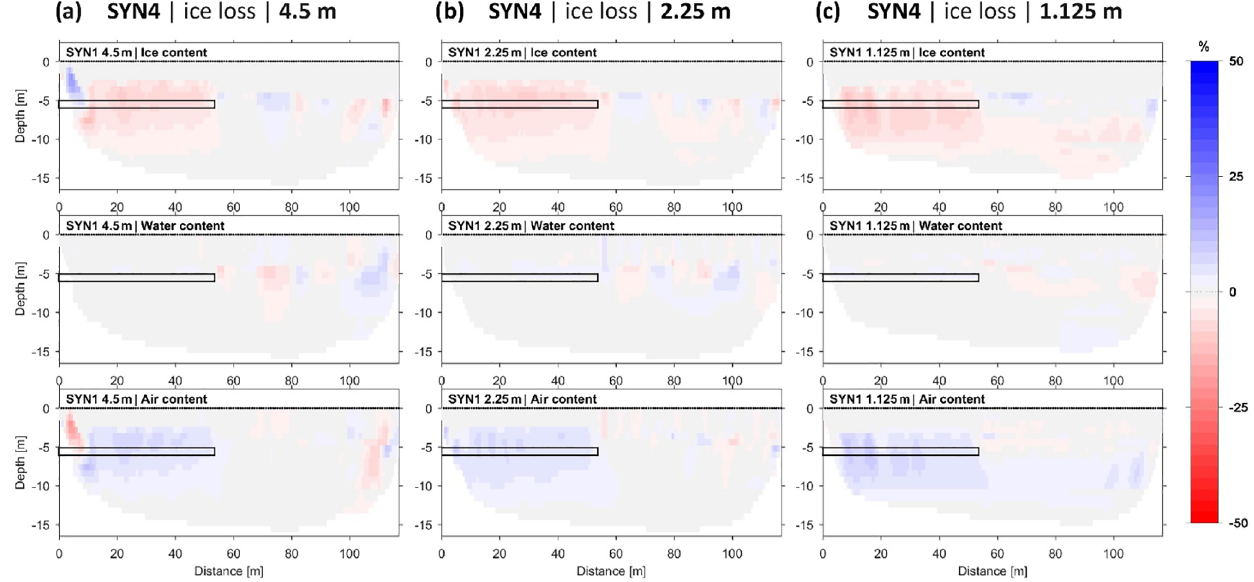
Figure 12. Comparison of 4PM-calculated changes in volumetric fractions for the inverted synthetic data of scenario SYN4 for three different sensor spacings: (a) 4.5m, (b) 2.25m, and (c) 1.125m. The position of the introduced change is indicated by black lines.